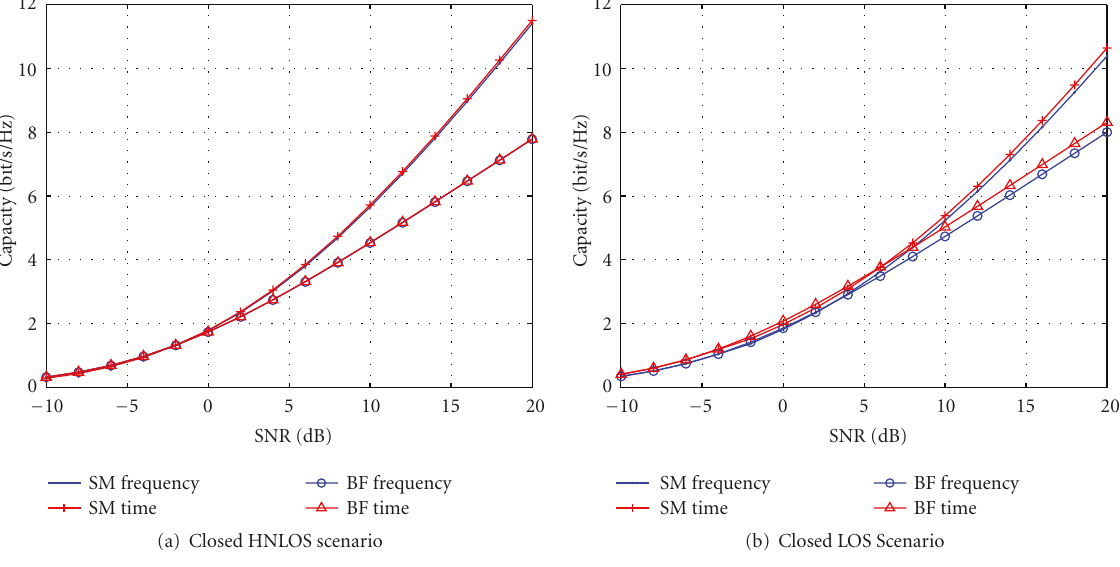
Figure 11: Average Capacity with frequency averaging versus time